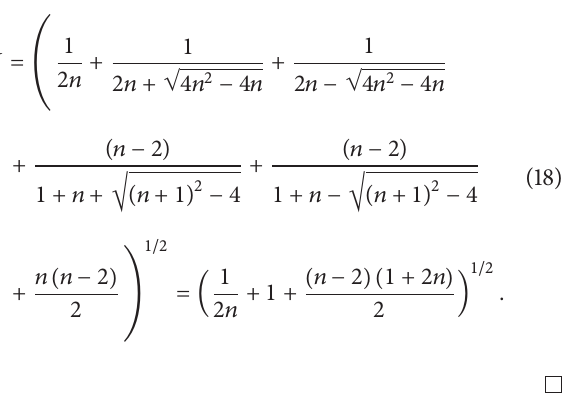
Figure 16: The communication topology 𝑆 4 ∘ 𝑆 4 ( 𝑛 = 5 , 𝑘 = 4